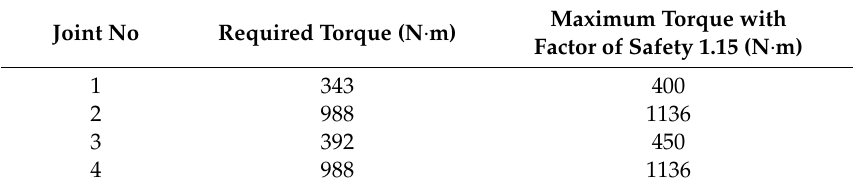
Table 6. Maximum required torque.